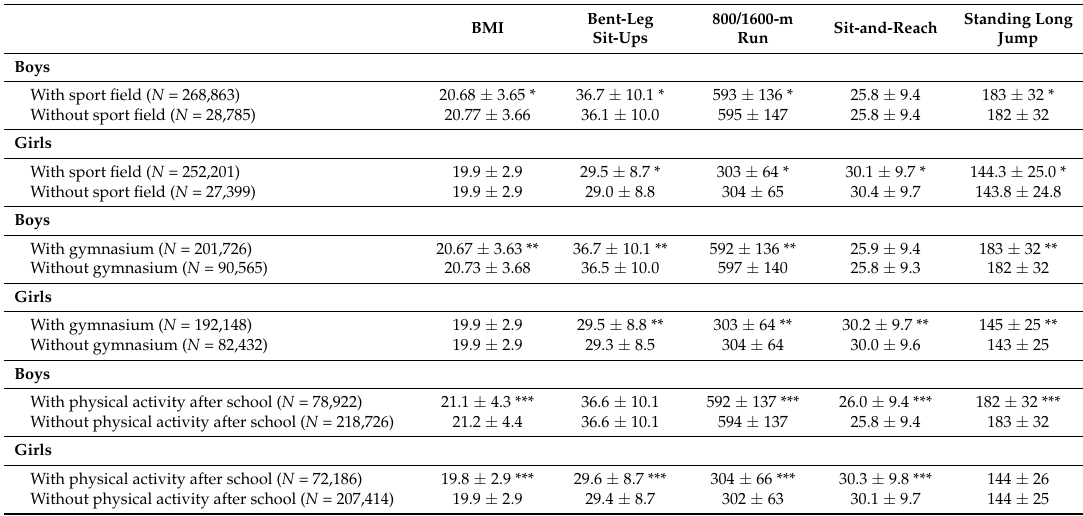
Table 3. Health-related physical fitness measurements for participants, grouped according to their schools’ facilities and whether they exercise after school. BMI Bent-Leg Sit-Ups 800/1600-m Run Sit-and-Reach Standing Long